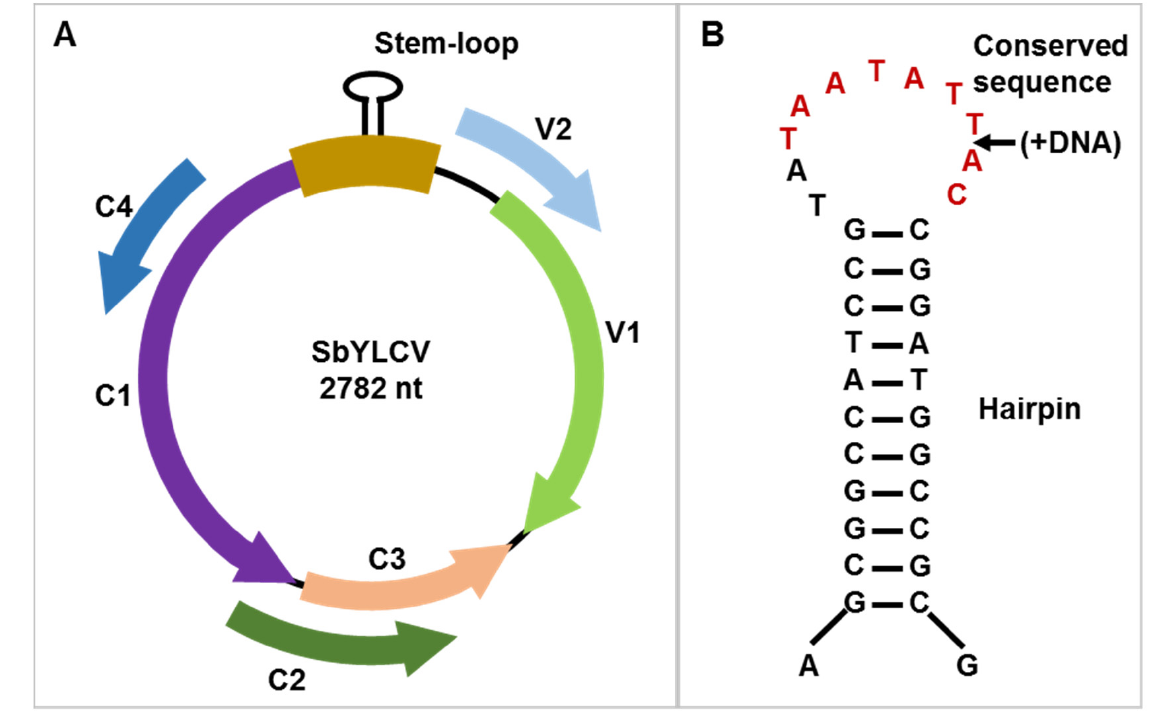
Figure 1. Genome organization of soybean yellow leaf curl virus (SbYLCV). ( A ) Schematic representation of SbYLCV genomic organization. Open reading frames encoded on the virion-sense (V) strand and complementary-sense (C) strand are denoted with different colors. ( B ) The stem-loop structure located within the intergenic region of SbYLCV. The conserved nonanucleotide sequence is shown in red color. The putative nick site within the nonanucleotide sequences is marked with an arrow. Table 1. ORFs and encoded proteins in the genome of soybean yellow leaf curl virus. Nucleotide ORF Orientation Coordinates